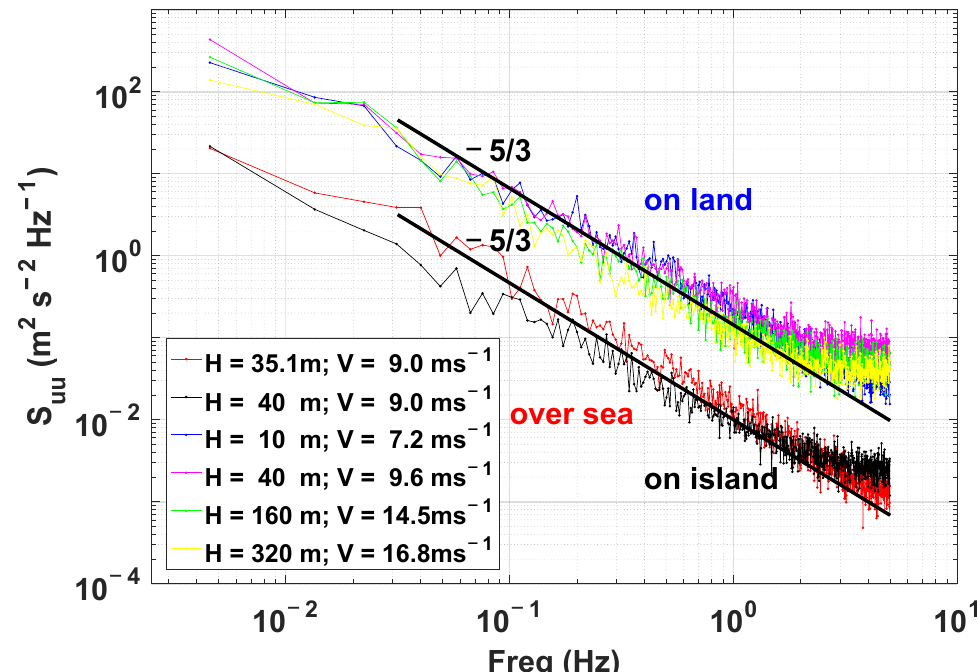
Figure 6. The power spectral density of the along-wind velocity during typhoons. The different color lines represent the measurements in different environments. The yellow, green, red, and blue lines show the measurements collected at the tower on land at 8:00 on 23 August 2017 during Typhoon Hato. The magenta line stands for the measurements collected at the tower on the island at 14:00 on 21 July 2017 during Typhoon Chanthu. The black line shows the measurements collected at the tower over sea at 23:00 on 28 September 2011 during Typhoon Nesat. The black lines are the 5/3 slope.